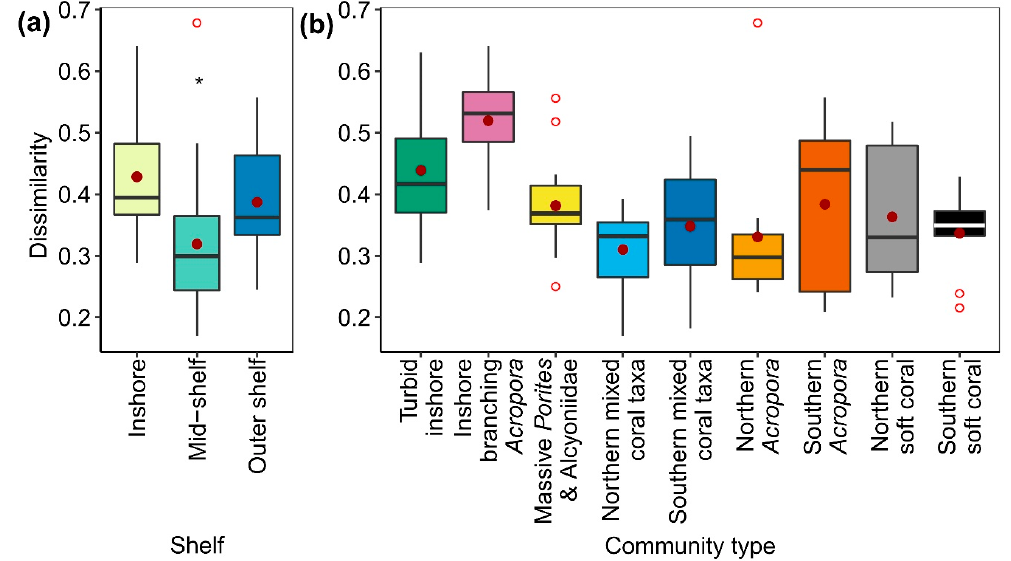
Figure 4. Boxplot of dissimilarity between juvenile and adult coral assemblages, where the line in the middle of each boxplot represents the median, colored portions contain the 25th to 75th percentiles of the observations and bars extent to 1.5 times the interquartile range. Solid dark red circles represent the mean and unusual observations are represented by red open circles ( a ) across the continental shelf and ( b ) for community type.